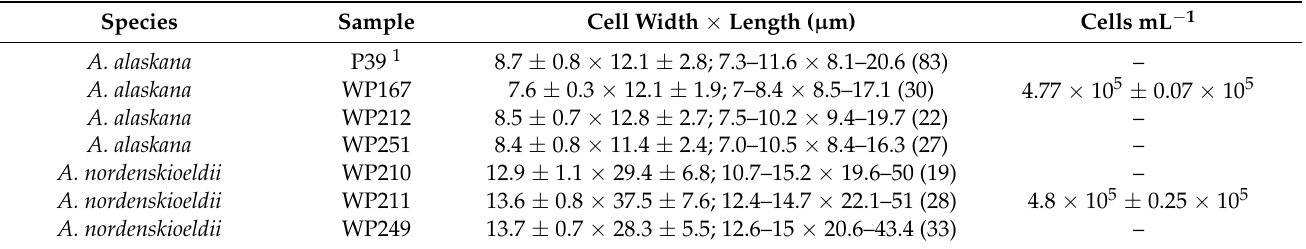
Table 2. Average cell sizes ( µ m) ± standard deviation and cell size ranges (with n = number of measured cells in brackets), and maxi- mum population densities ± standard deviation of the two glacial algae A. alaskana and A. nordenskioeldii are